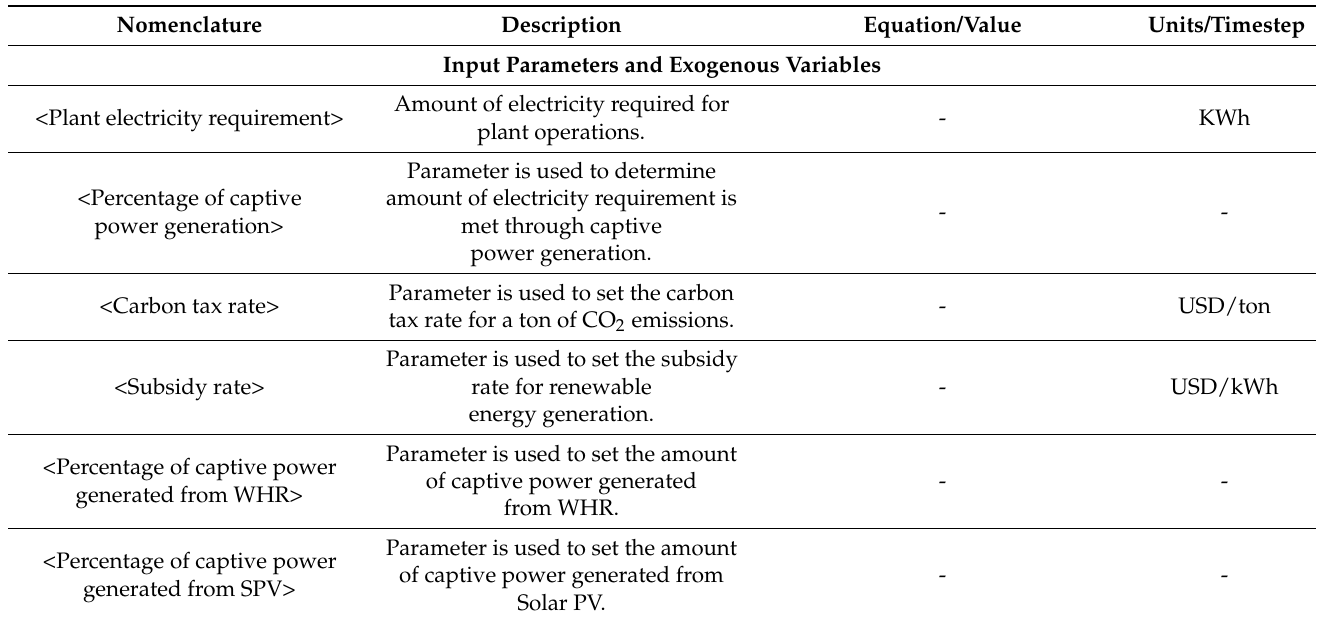
Figure 2. Stock-and-flow diagram of the proposed model for captive power generation in a cement plant. “Total CO 2 emissions” refers to the emissions from the plant through electricity utilisation. Abbreviations: SPV—solar photovoltaic system; WHR—waste heat recovery; NG—natural gas; CAPEX—capital expenditure. Table 1. Description of the variables utilised in the proposed model.